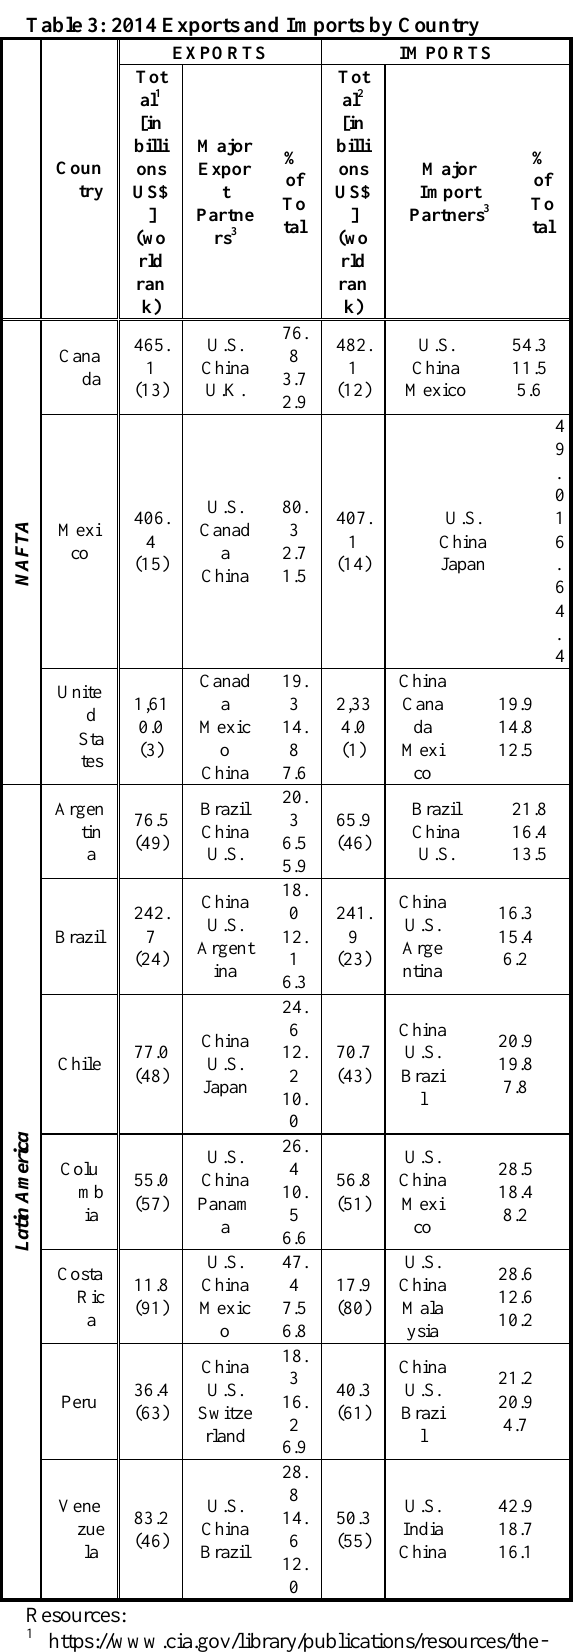
Table 3: 2014 Exports and Imports by Country EXPORTS